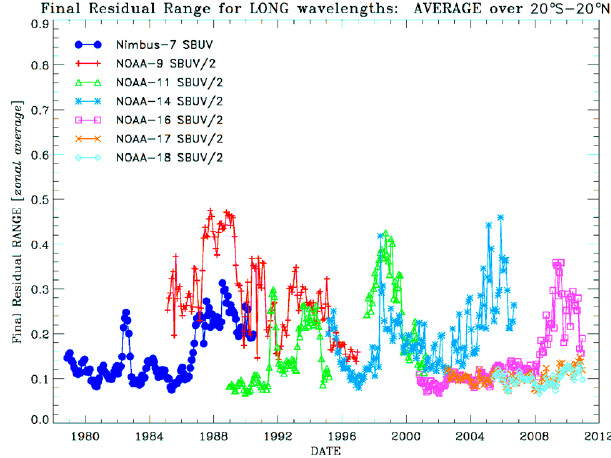
Fig. 20. Time series of final residual range for the shortest wave- lengths used in the V8.6 profile ozone retrieval (Res Short). All values are averaged over each month and 20 ◦ S–20 ◦ N latitude.